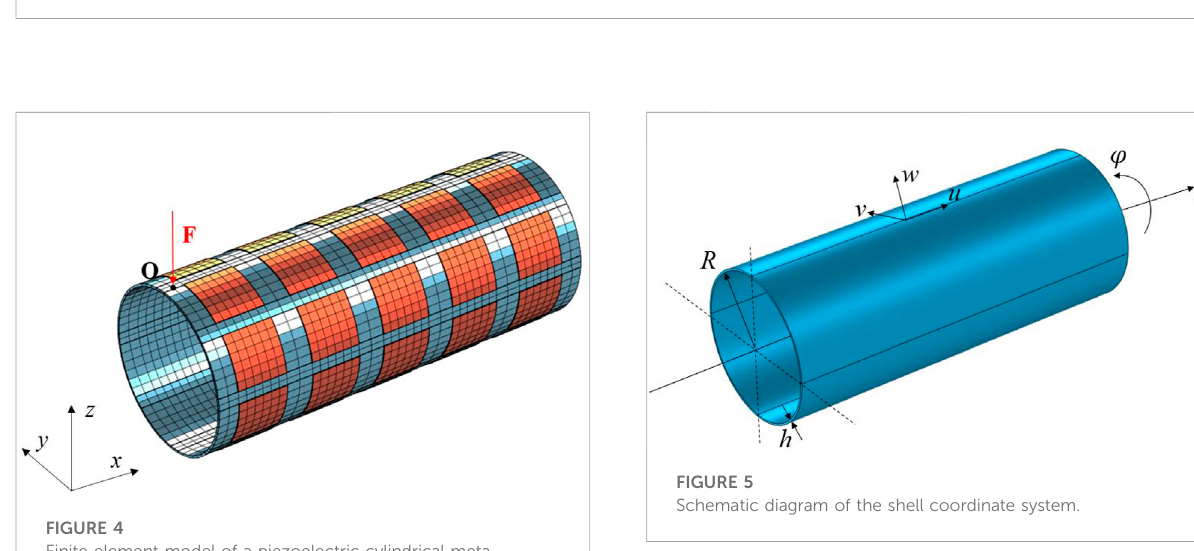
FIGURE 4 Finite element model of a piezoelectric cylindrical meta- shell.